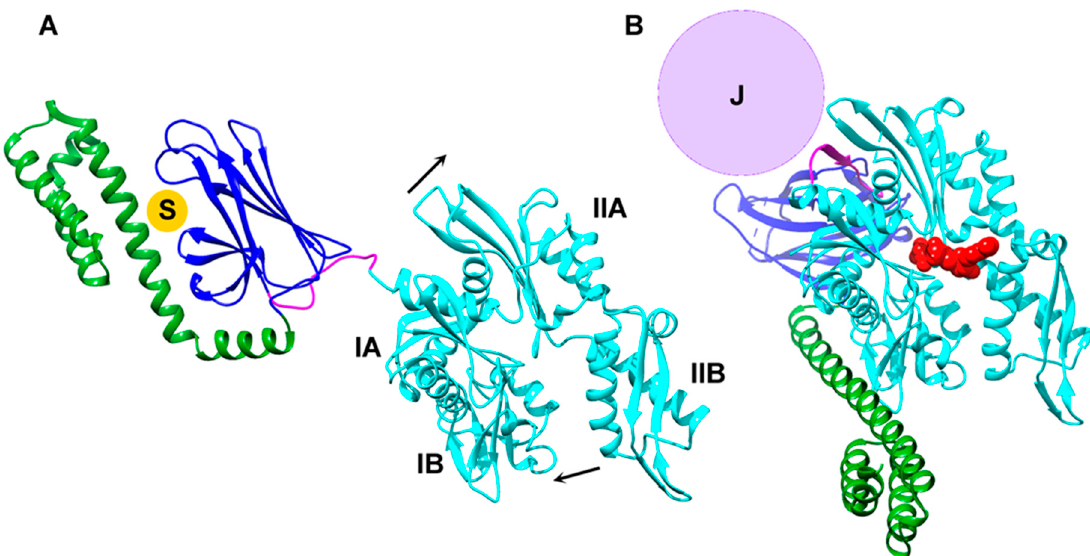
Figure 7. ATP energy is used to stabilize an Hsp70 conformation that disrupts interactions with NEFs and protein substrates, and forms the binding site for the J cochaperone. ( A ) Structure of bacterial Hsp70 (DnaK; 1KHO.pdb [25]) in the ADP state with the nucleotide binding domain (NBD) in cyan, the interdomain linker in magenta, and the β -sheet and helical subdomains of the substrate binding domain (SBD) shown in blue and green, respectively. This is the intrinsically more stable conformation which is also assumed in the absence of nucleotide [22], and which traps substrate proteins (“S”) as extended peptides between the helical and β -sheet parts of the SBD. ( B ) Structure of Hsp70 in the ATP conformation (1BQ9.pbd [23]). ATP binding induces closure of the NBD by hinging of lobe IIB towards lobe IB, and lobe IIA away from IA, as indicated by arrows in panel A. Closure of the NBD disrupts interactions with NEFs, which bind and stabilize open conformations of the NBD. Widening of the space between lobes IA and IIA allows the interdomain linker to bind in this space and extend the lobe IIA β -sheet. These changes create binding sites for the J cochaperone (which binds in the space defined by sphere labeled “J”) and for the β -sheet and helical parts of the SBD, resulting in opening of the latter and release of bound